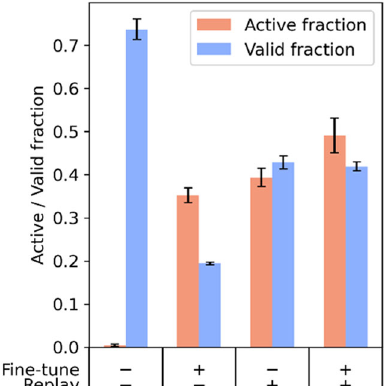
Fig. 2 Combined effects of fi ne-tuning and reinforcement learning. Four conditions are shown here, representing the four combinations of fi ne- tuning and experience replay. From left to right, the conditions are: (1) no experience replay and no fi ne-tuning, (2) fi ne-tuning only, (3) experience replay only, and (4) both experience replay and fi ne-tuning. Models were trained for 20 epochs. Conditions with fi ne-tuning used 20 iterations of fi ne-tuning; those without used 0 iterations of fi ne-tuning. All training epochs had 25 policy steps, with different ratios of experience replay and policy gradient. Conditions with experience replay used 10 iterations of experience replay and 15 iterations of policy gradient; those without used 0 iterations of experience replay and 25 iterations of policy